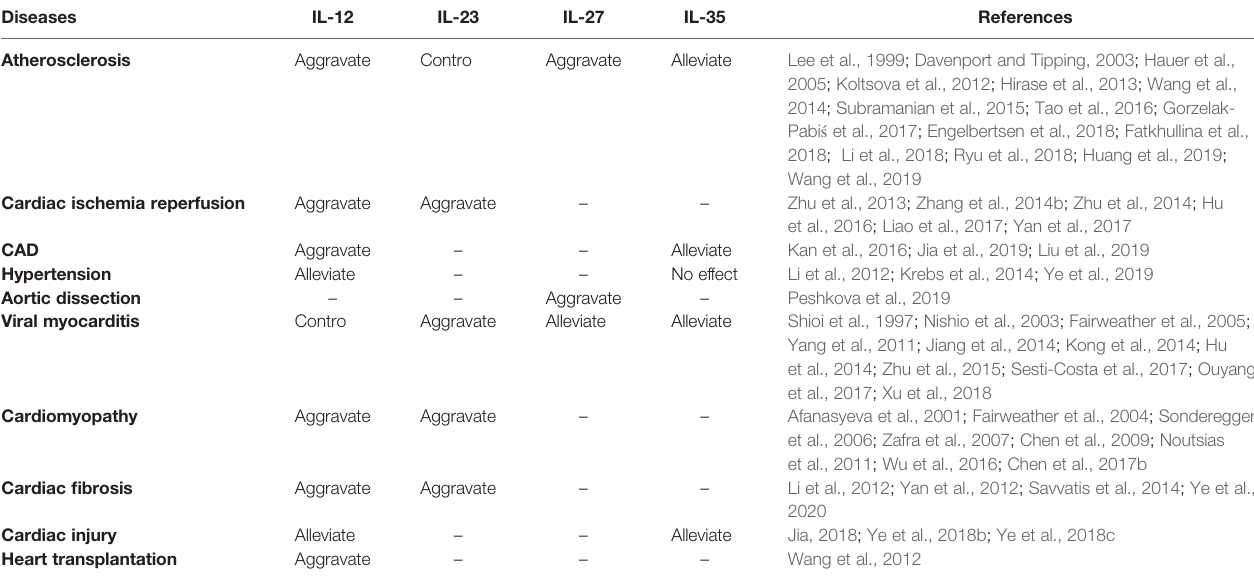
TABLE 4 | Regulation of IL-12 family members on cardiovascular